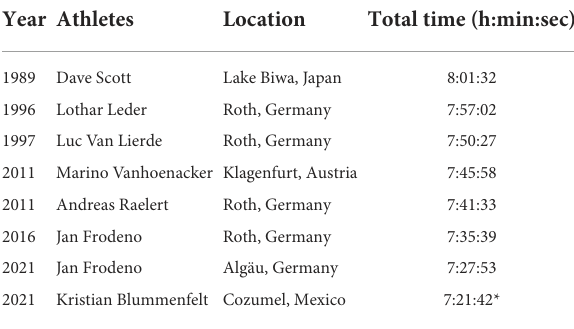
TABLE 1 World record Ironman TM triathlon performances.